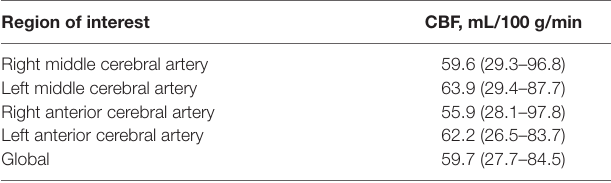
TaBle 1 | Cerebral blood flow (CBF) during the early brain injury phase following aneurysmal subarachnoid hemorrhage. region of interest Right middle cerebral artery